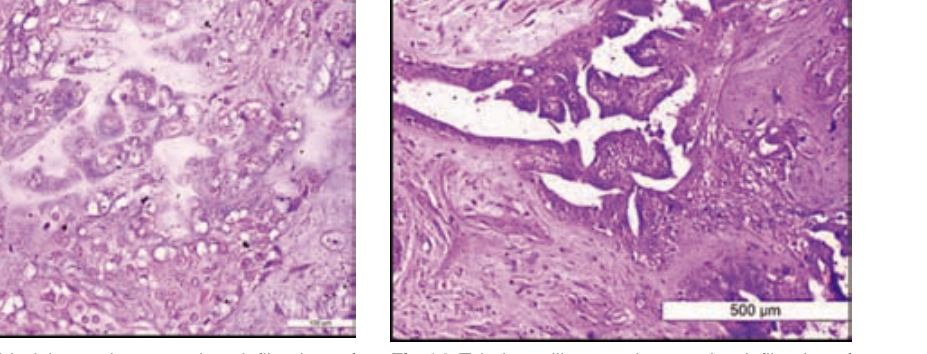
Fig.13. Lipid rich carcinoma – low infiltration of Tumour Associated Macrophages (H&Ex400)